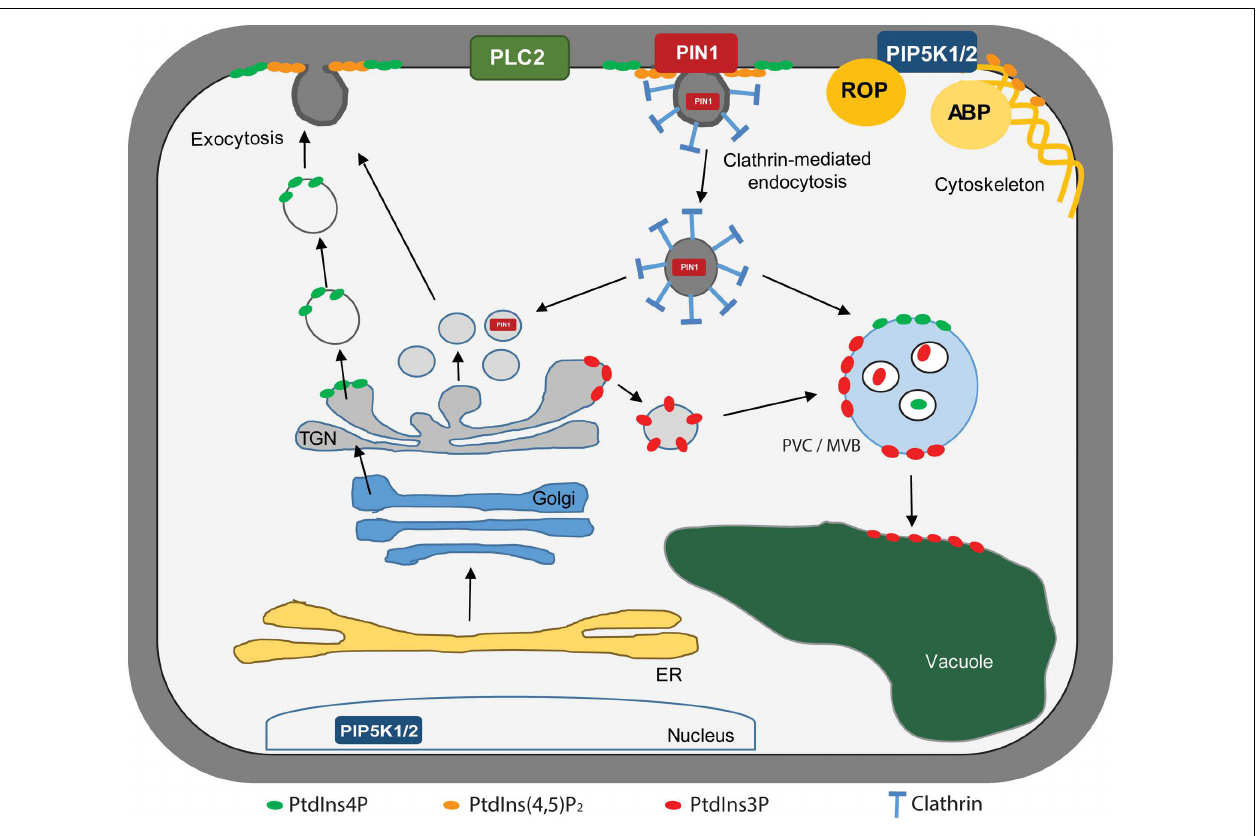
FIGURE 3 | Asymmetrical phosphoinositide distribution across the subcellular membranes. Phosphoinositide-interacting proteins as well as phosphoinositide biosynthetic enzymes have been represented within a plant cell. PLC2, PHOSPHOLIPASE C 2; PIN1, PIN-FORMED 1; PIP5K1/2, PtdIns4P-5-KINASE 1/2; ROP, RHO OF PLANTS; ABP, ACTIN BINDING PROTEIN, TGN, Trans-Golgi Network; ER, Endoplasmic Reticulum; PVC/MVB, Prevacuolar Compartment/Multivesicular